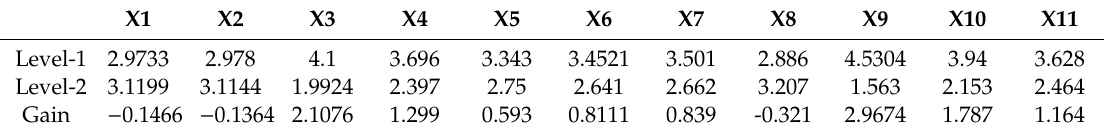
Table 9. Average S / N ratios and gain for each feature.